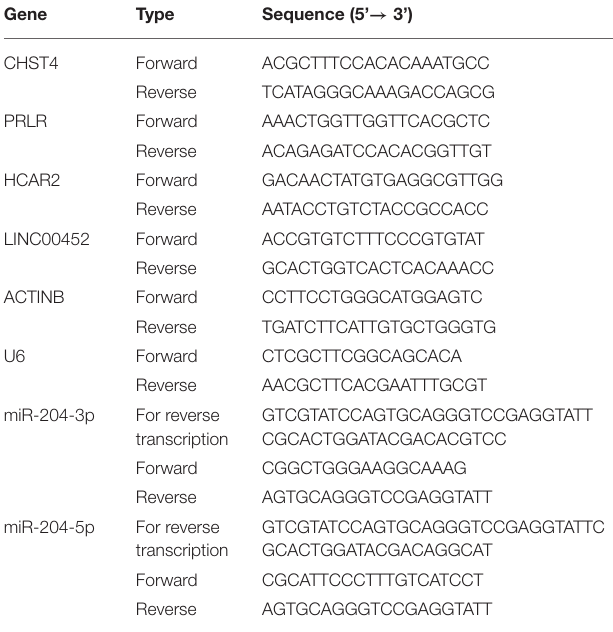
TABLE 2 | The primer for